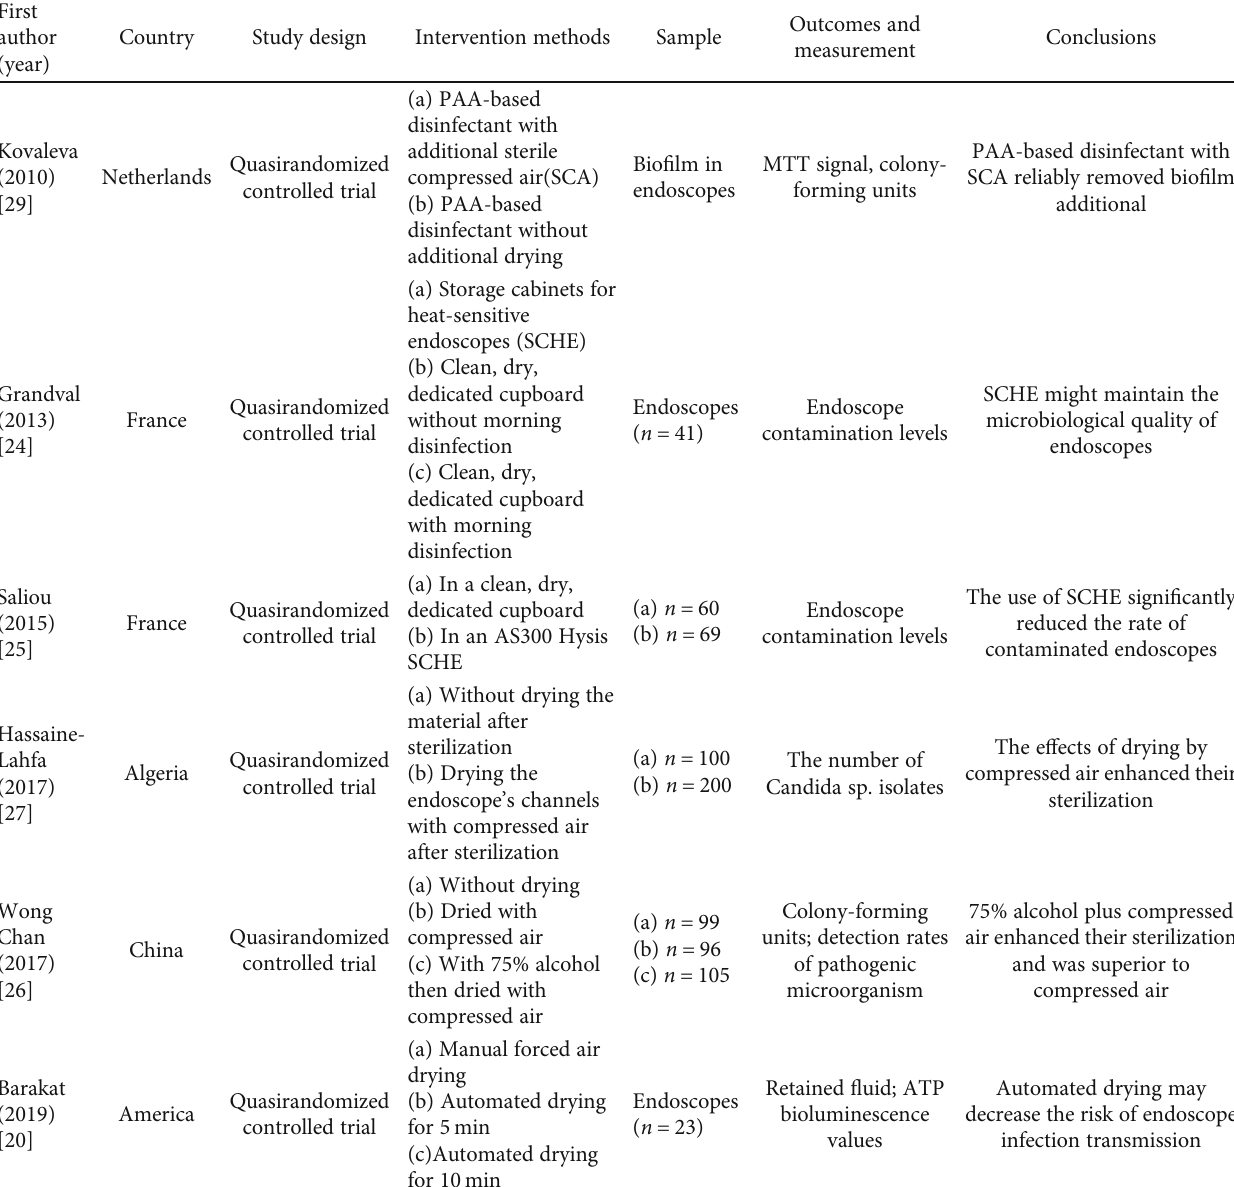
Table 1: Characteristics of the quasi-randomized controlled